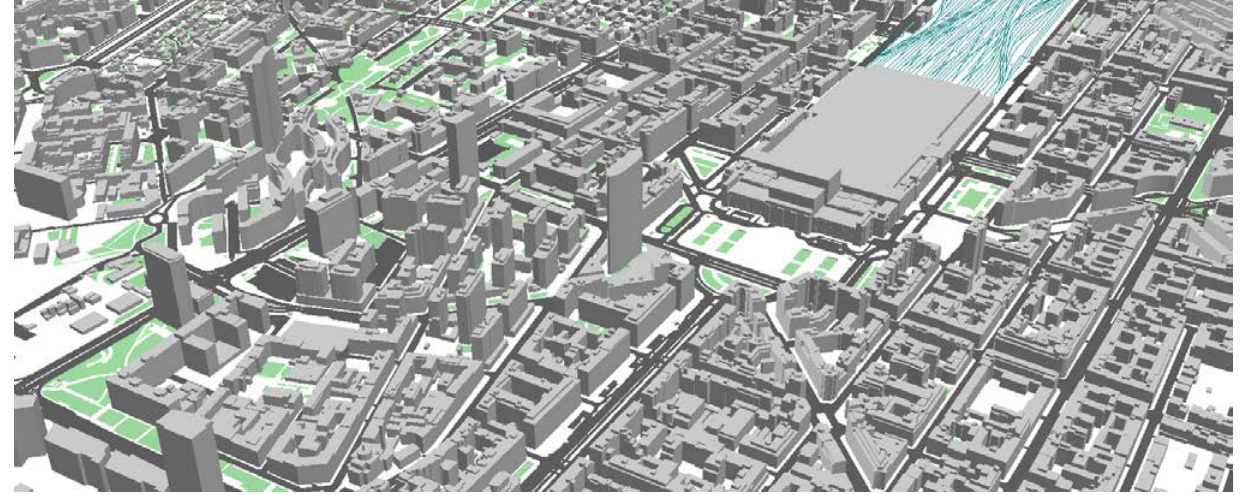
Figure 1. Topographic Database of the city of Milan: central station